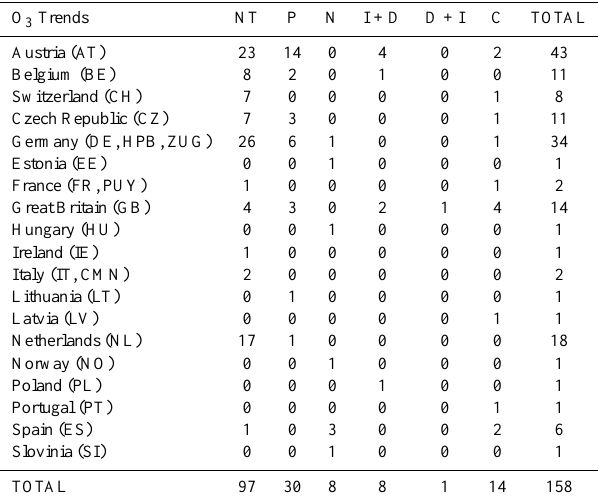
Table 2. Manual categorisation of O 3 time series by loess smooth- ing. NT – no trend, P – positive trend, N – negative trend, I + D increasing then decreasing levels, D + I – decreasing then increas- ing levels, C – complex